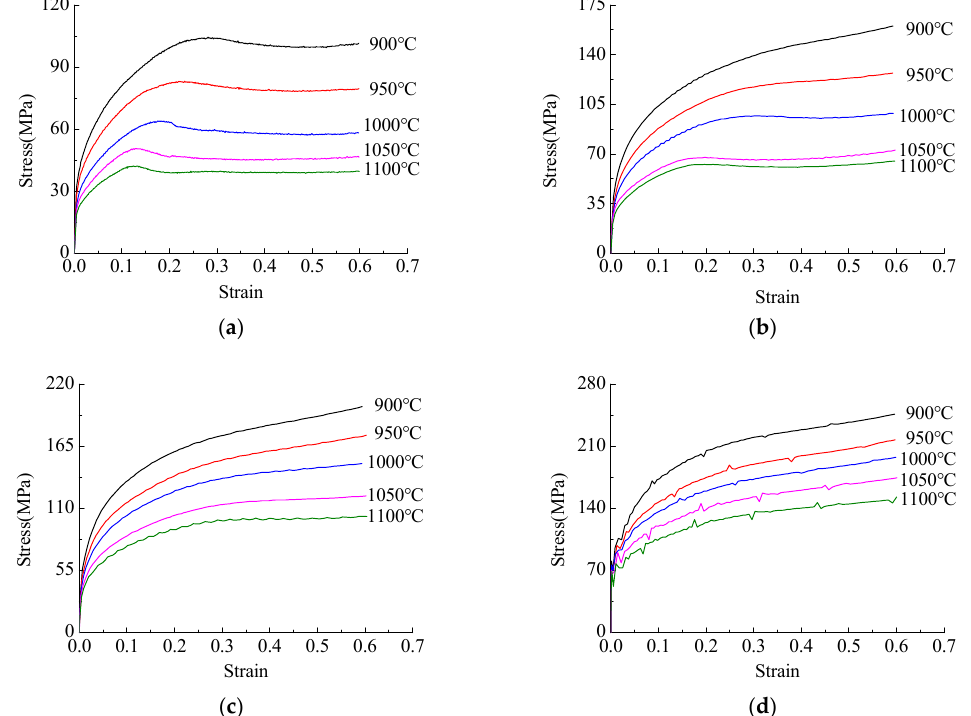
. ε = . ε = . ε = 0.01s − 1 ; ( b ) 0.1s − 1 ; ( c ) 1.0 s − 1 ;